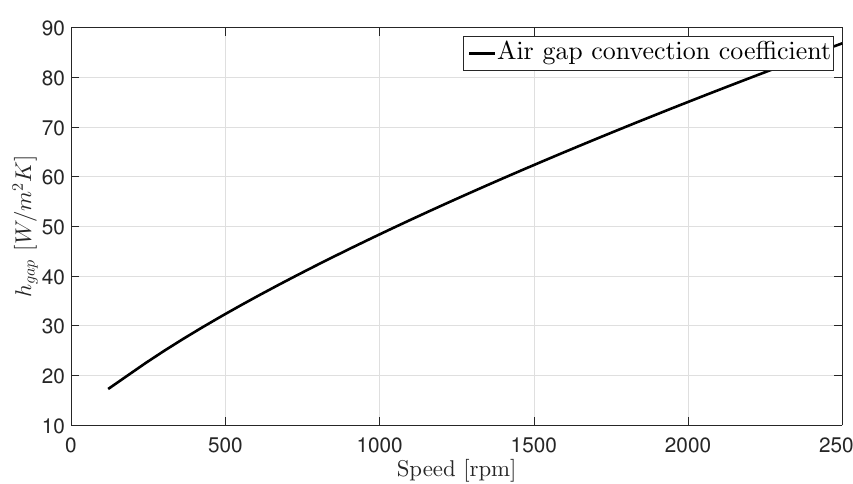
Figure 16. The air gap convection coefficient variation with the